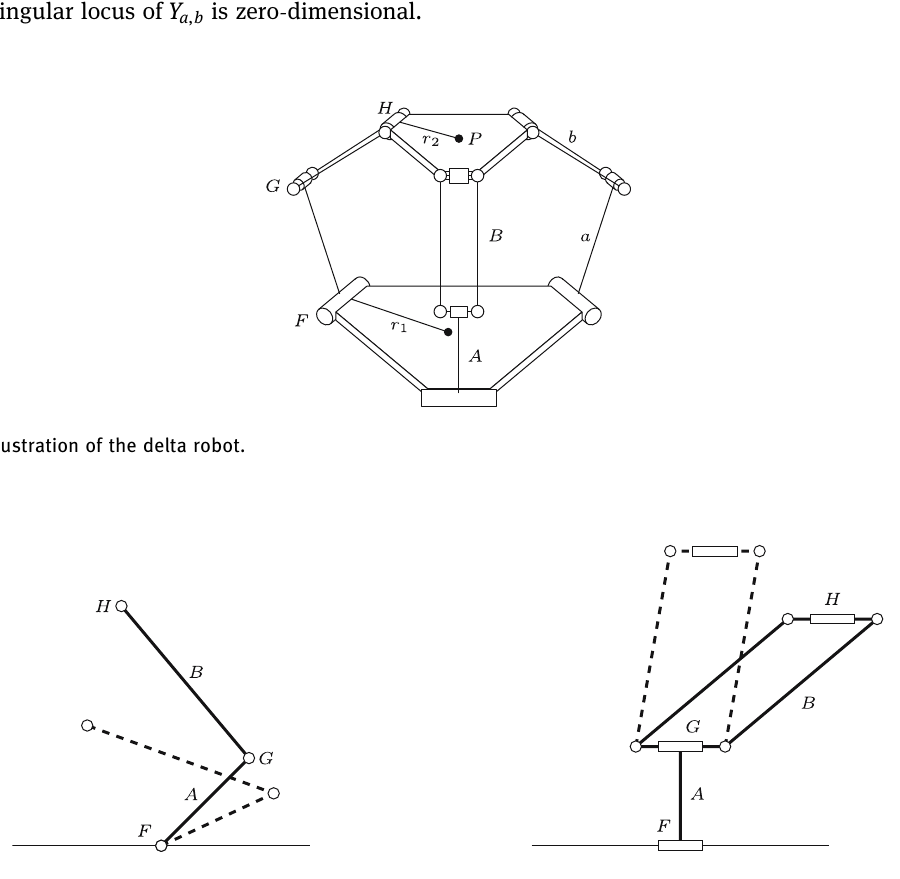
Figure 8: One arm of the delta robot. Front and side views in di ff erent con fi